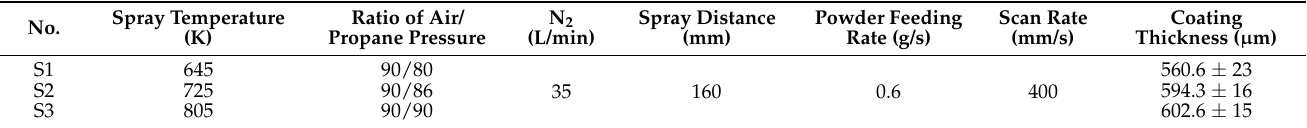
Table 2. The amorphous coating preparation